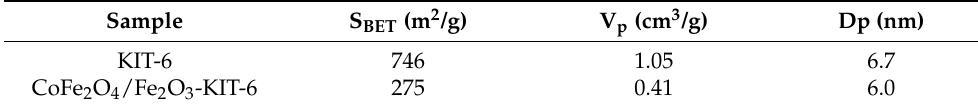
Table 1. Textural parameters of the solids.